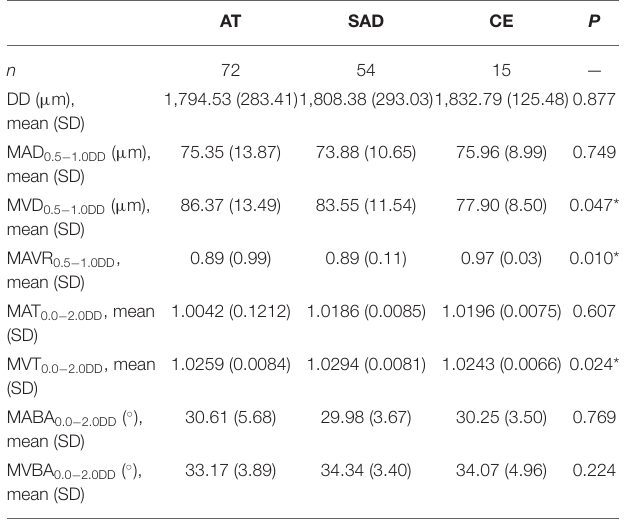
TABLE 2 | Comparison of retinal vascular parameters among AT, SAD, and CE subtypes. AT SAD CE